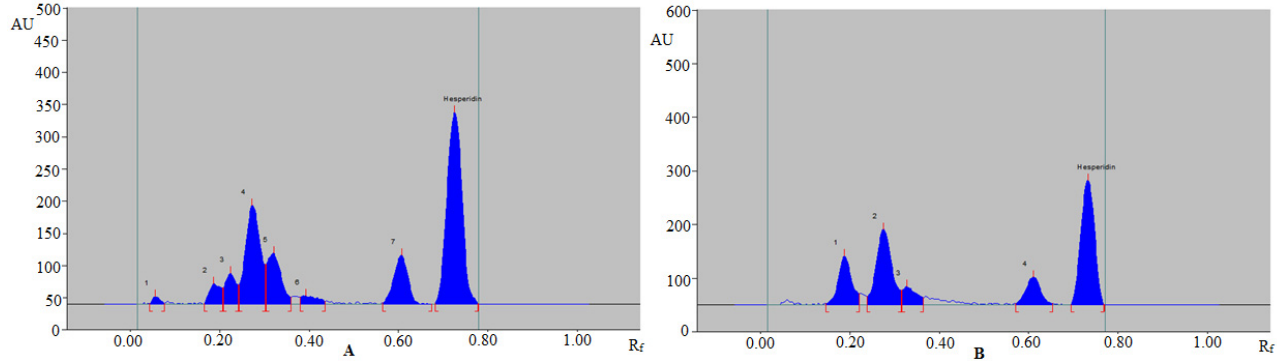
Figure 3. Overlaid spectrodensitograms of ( A ) standard HSP, ( B ) grapefruit peels, ( C ) lemon peels, ( D ) mosambi peels, ( E ) orange peels, ( F ) commercial formulations A, and ( G ) commercial formulations B.